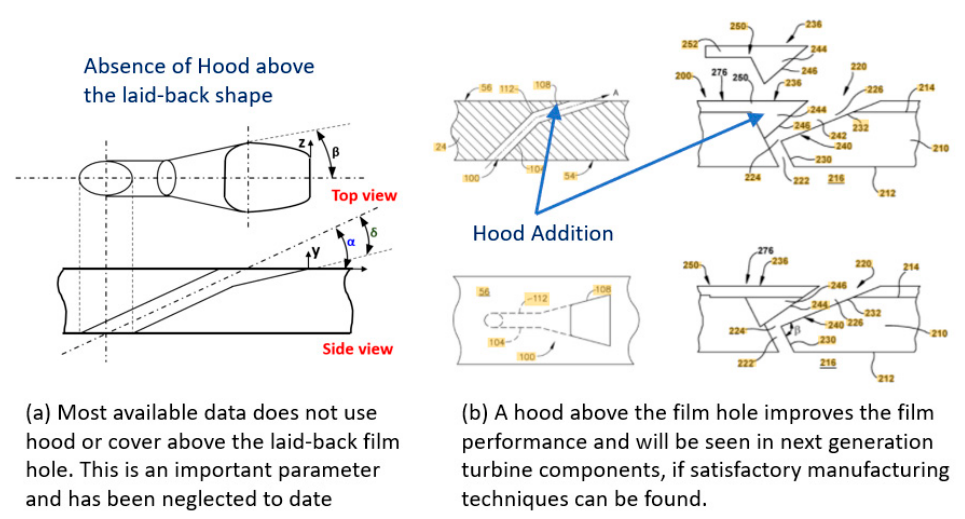
Figure 5. Popular design configurations of film cooling holes [30,31] are schematically illustrated in ( A – D ). More configurations are available in [32].